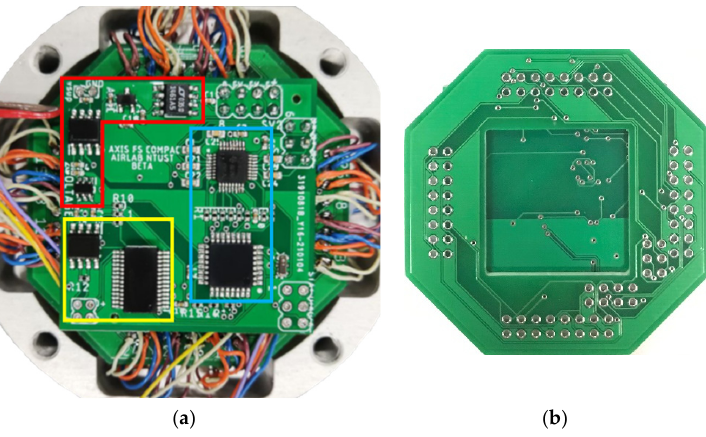
Figure 11. PCB layout of integrated DAQ ( a ) front ( b ) back.